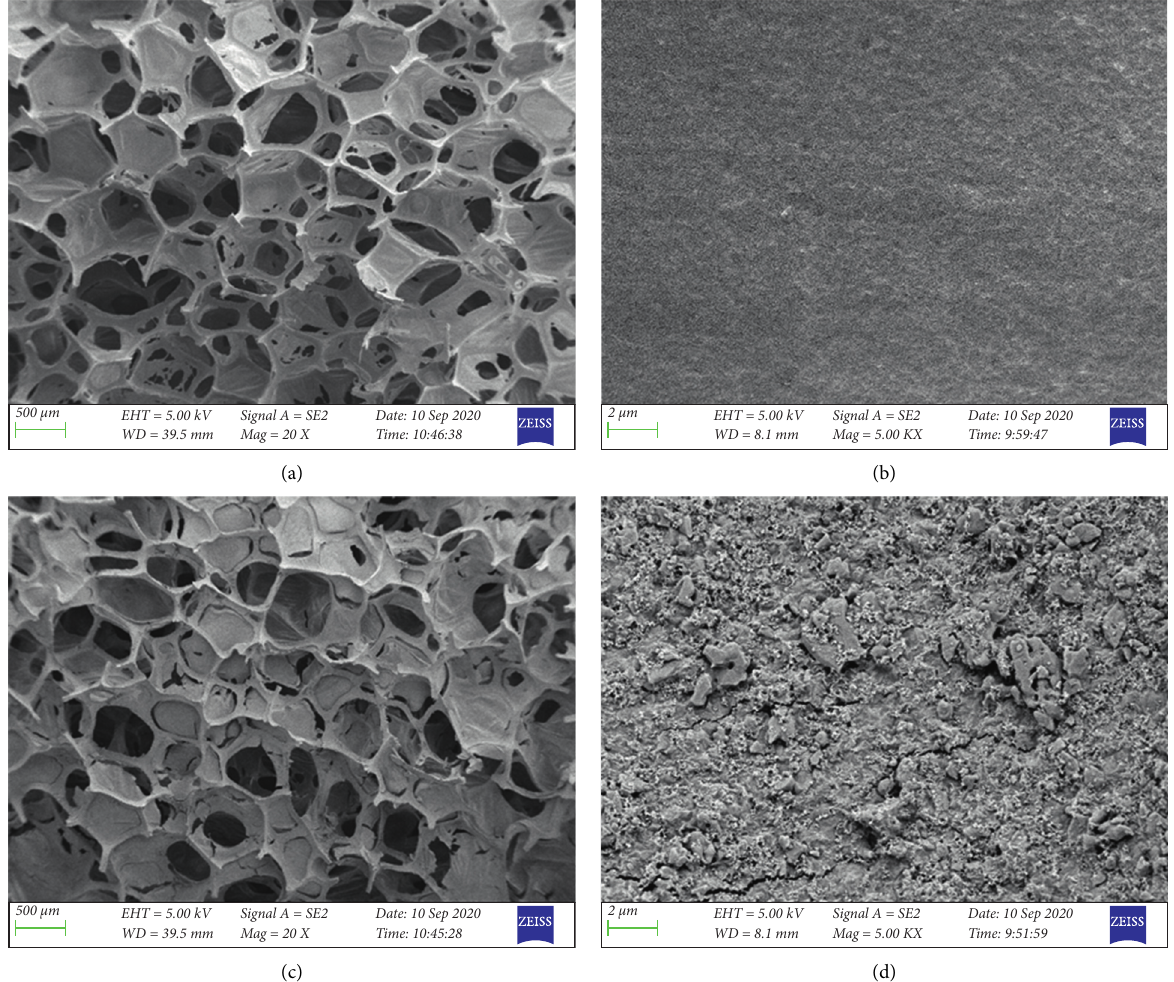
Figure 2: SEM images of (a, b) PU foam and (c, d) Al